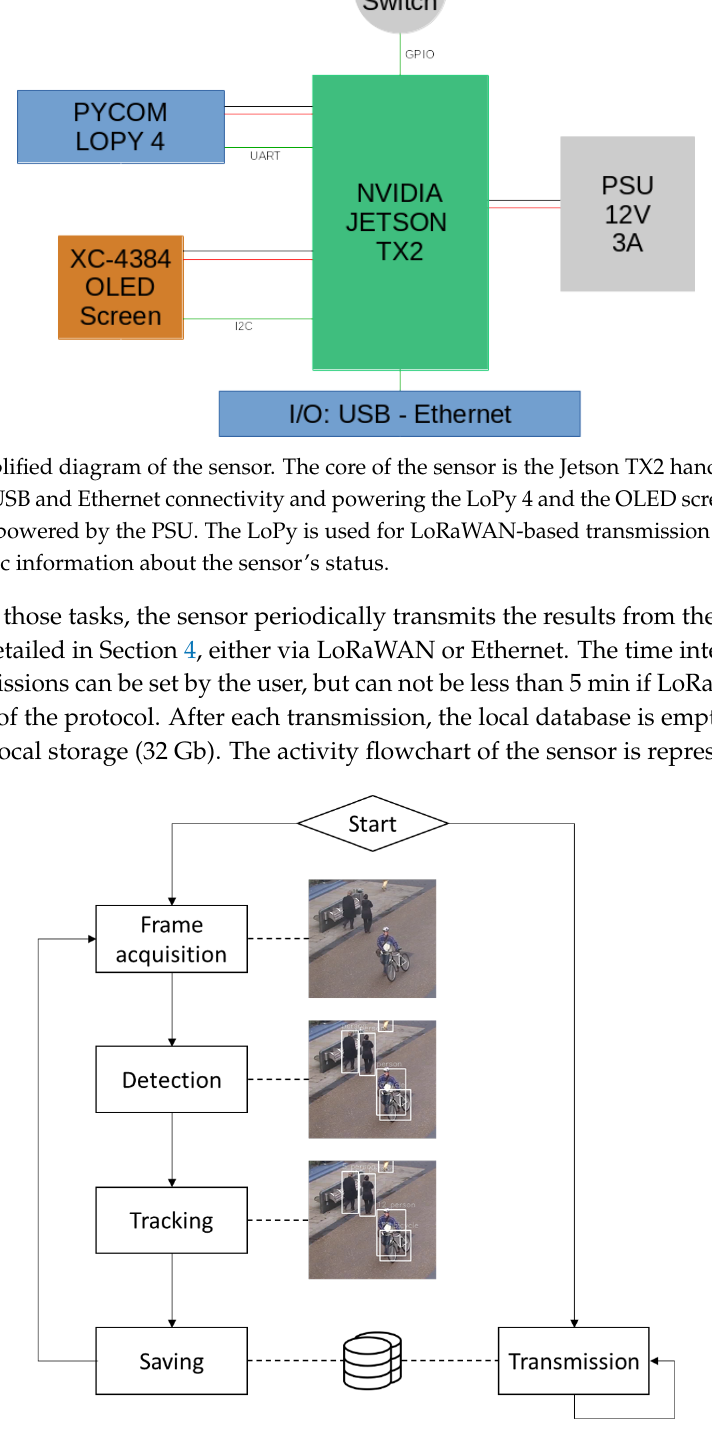
Figure 4. Activity flow chart of the